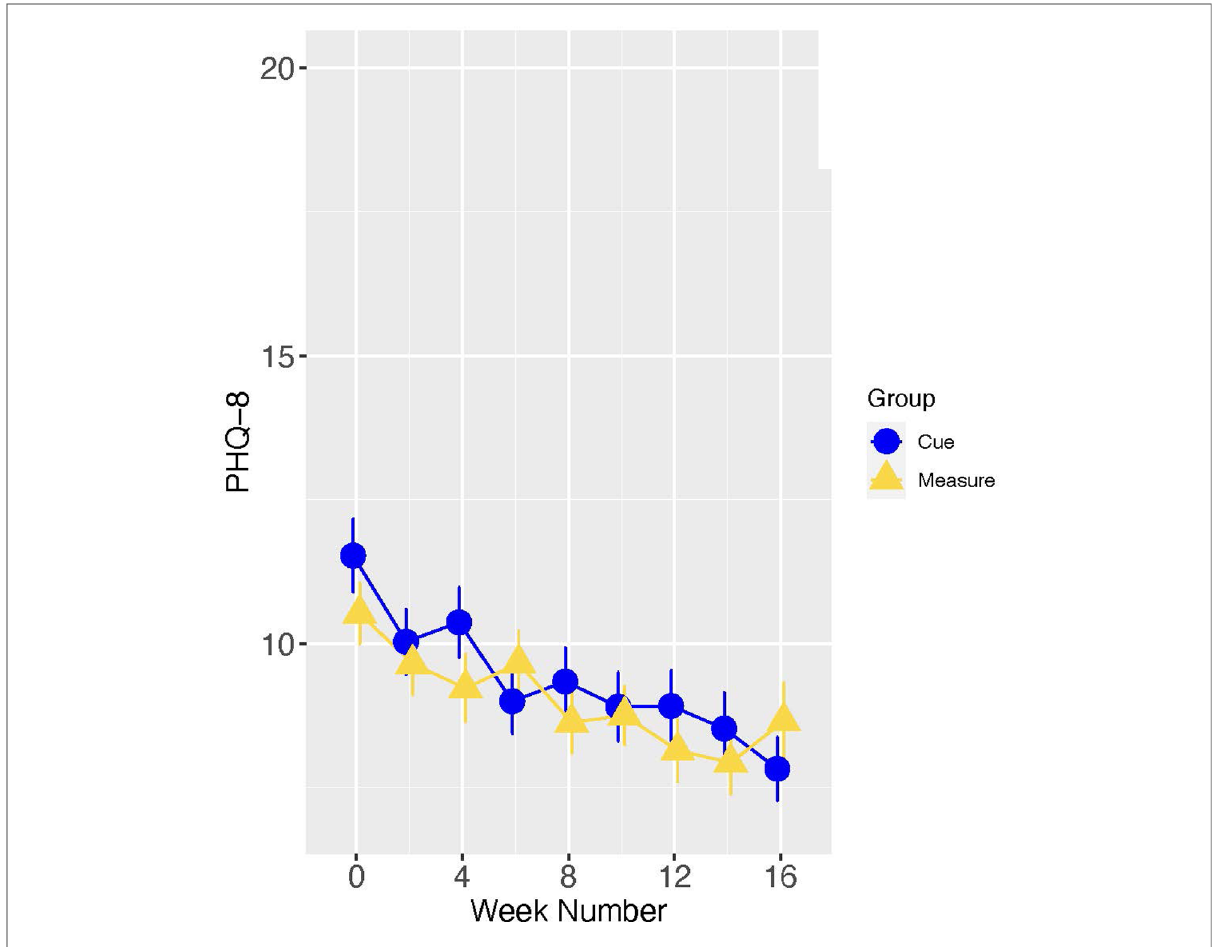
FIGURE 6 Means and standard errors of PHQ scores by study week-full